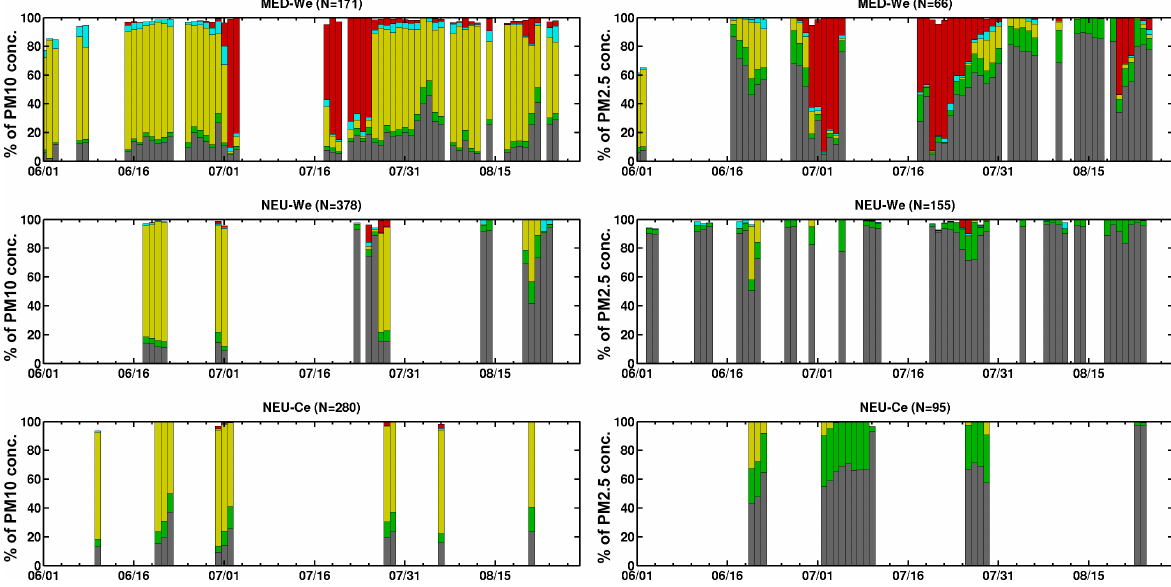
Figure 14. Simulated relative contribution of each source type to surface PM 10 and PM 2 . 5 concentrations during the summer of 2012 (1 June to 31 August 2012), on average when exceedances of the daily air quality threshold are detected only by the model at the stations ( N is the number of stations in each region).